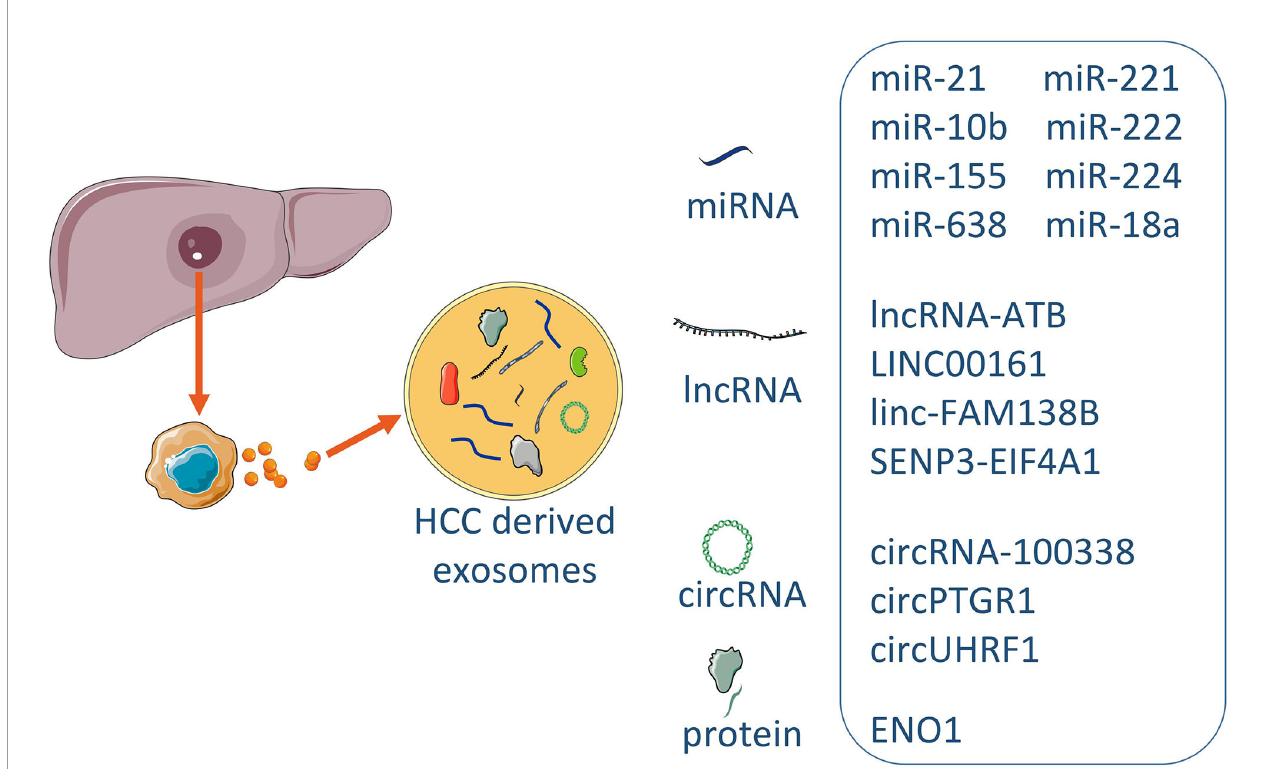
FIGURE 2 | The exosomal biomarkers in HCC. Exosomes derived from HCC contained the different consist of cargoes of miRNAs, lncRNAs, circRNAs and proteins. Some speci fi c molecules can be utilized for typical exosome biomarkers, and early prediction and prognosis of